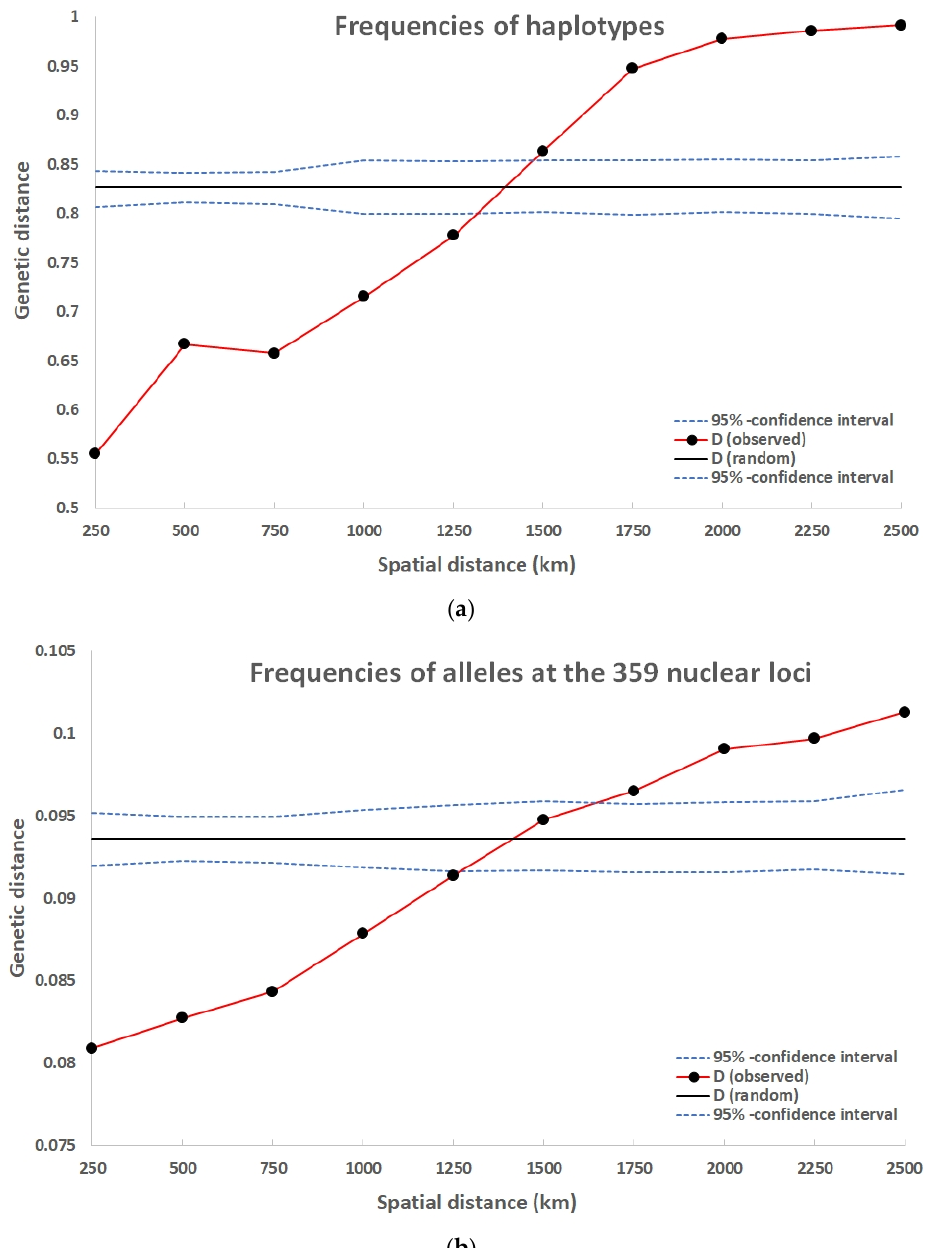
Figure 3. Distograms of the spatial pattern for ( a ) frequencies of haplotypes and ( b ) frequencies of alleles at the 359 nuclear loci.